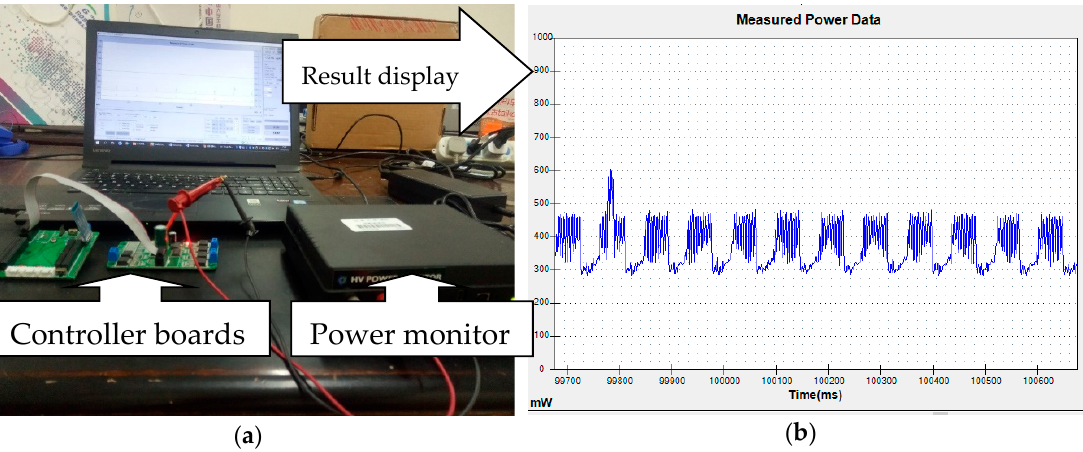
Figure 9. Power measurement of the controller boards. ( a ) Control boards power measurement; ( b ) Power result.